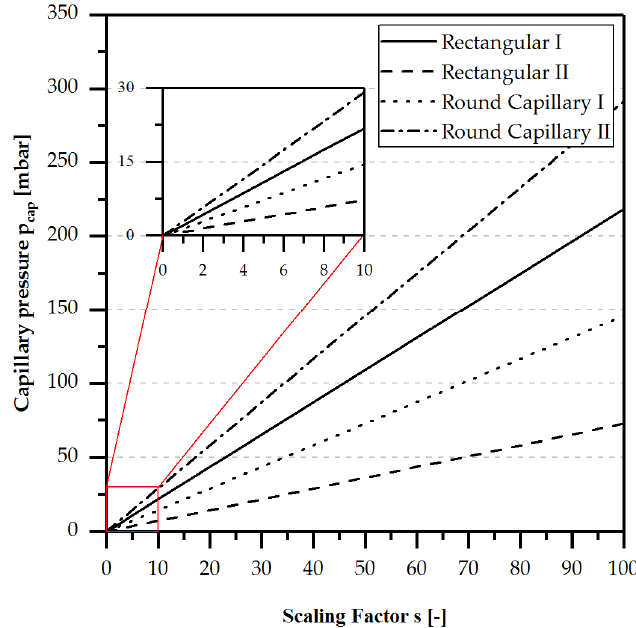
Figure 1. Capillary Pressure p for water at 20 ◦ C, σ H = 0.07275 N/m , dependent on channel geometry, surface properties, and material combination. Rectangular I (wall contact angle: 60 ◦ , width: 1 mm, height: 0.5 mm) without a hydrophobic membrane on the top of the micro channel. Rectangular II (wall contact angle: 60 ◦ , width: 1 mm, height: 0.5 mm) with hydrophobic membrane made of PTFE (contact angle: 120 ◦ [20]) on the top of the micro channel. Round Capillary I (wall contact angle: 60 ◦ , diameter: 1 mm). Round Capillary II (wall contact angle: 60 ◦ , diameter: 0.5